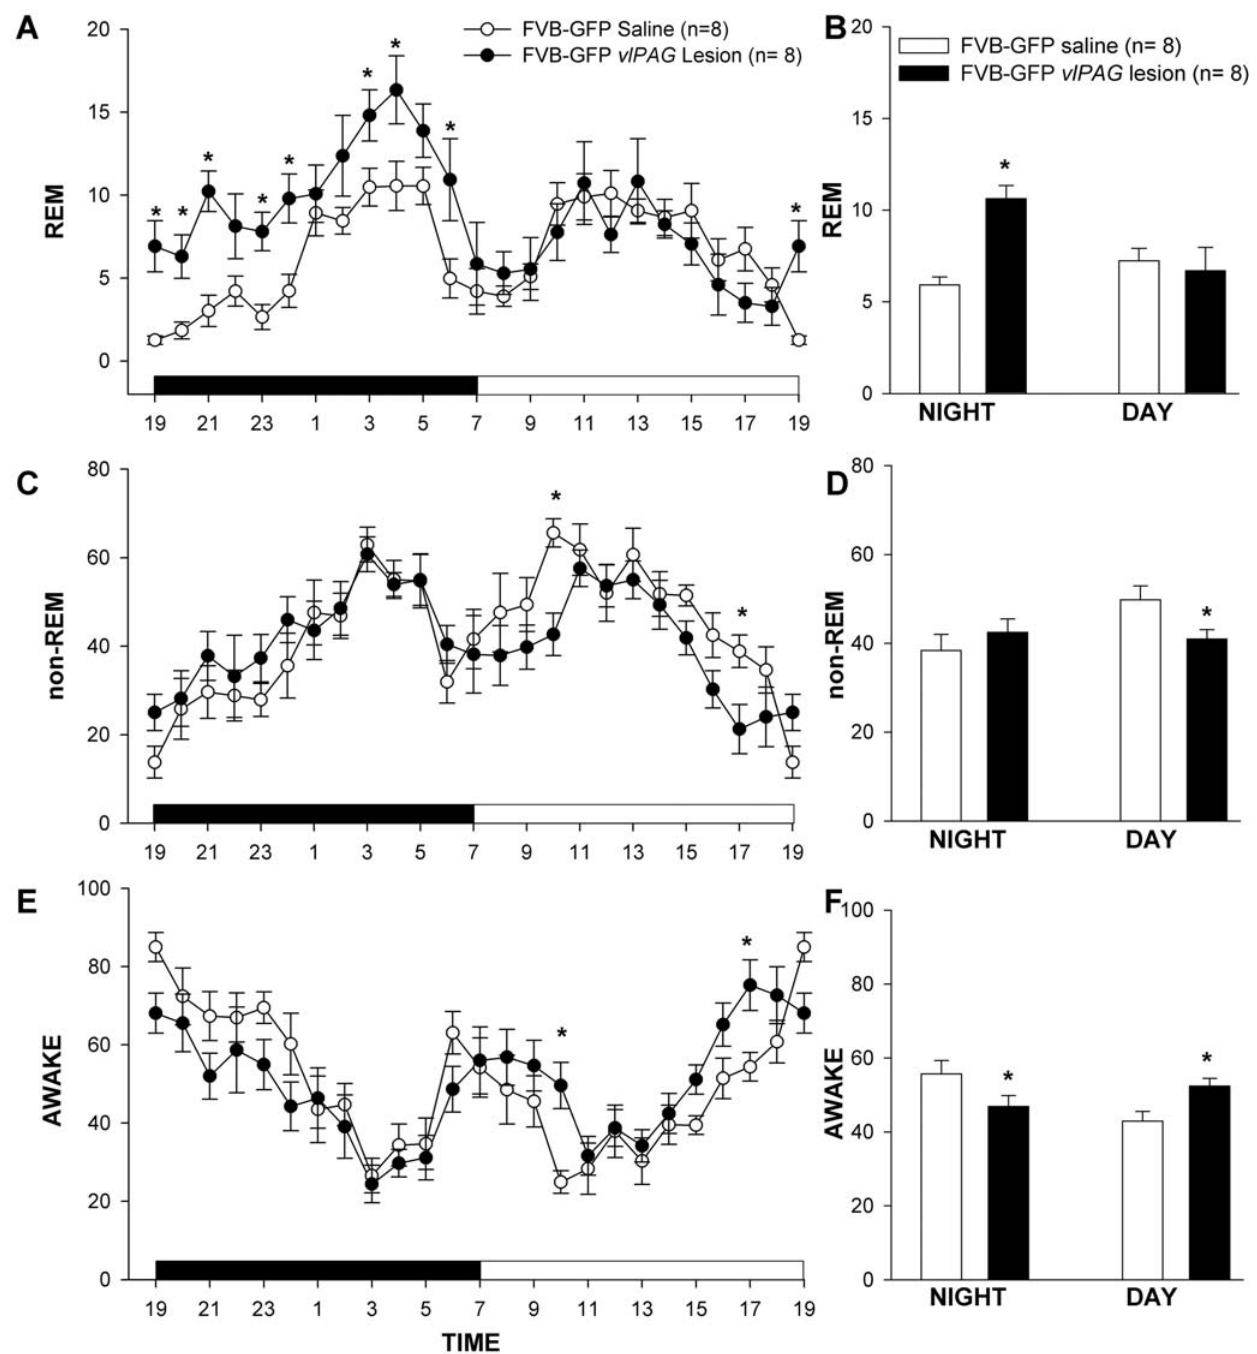
C, E) represents the lights-off period and the white bar represents the lights-on period of 12:12 h of the L:D cycle. The bar graphs (B, D, F) represents the average ( 6 SEM) REM, NREM and wake levels during the 12 h day and night periods. Significance levels- single asterisk (*) represents the P , 0.01 for FVB-GFP saline vs. FVB-GFP vlPAG lesion.